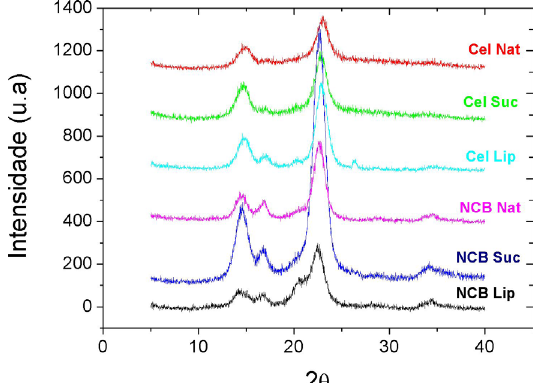
Figure 7. Cellulose DRX and pristine, succinylated and immobilized nanocellulose with